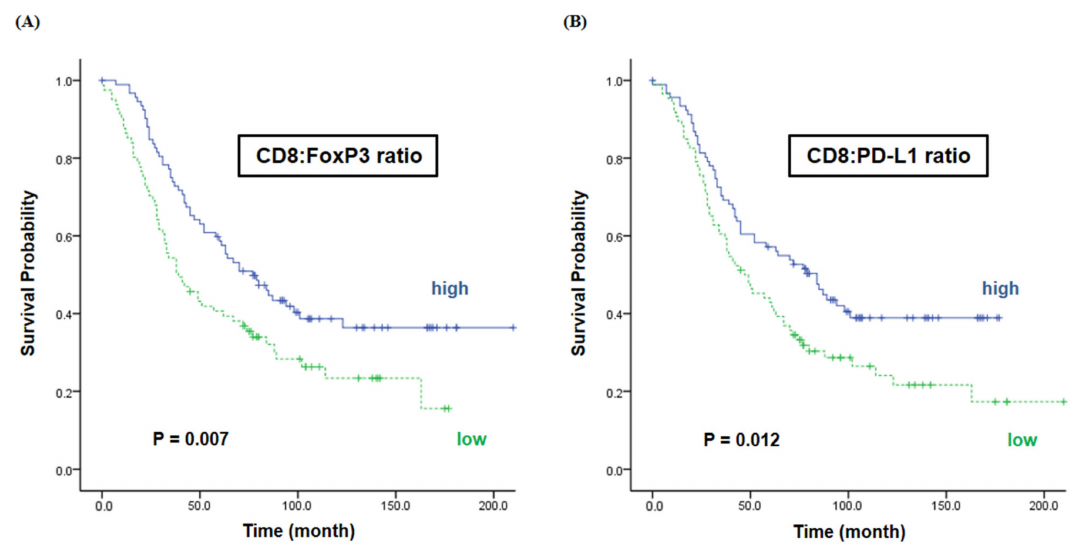
Figure 4. Overall survival according to the ratios of CD8 vs. FoxP3/PD-L1. We classified patients according to the ratio of marker expression, CD8 to FoxP3 and CD8 to PD-L1, and analyzed overall survival according to their ratio. As a result, these two expression ratios of immune markers were significantly associated with survival rate. ( A ) The median OS was 77 months in the high CD8 to FoxP3 ratio group and 39 months in the low CD8 to FoxP3 ratio group ( p = 0.007). ( B ) The median OS was 84 months in the high CD8 to PD-L1 ratio group and 47 months in the low CD8 to PD-L1 ratio group ( p =